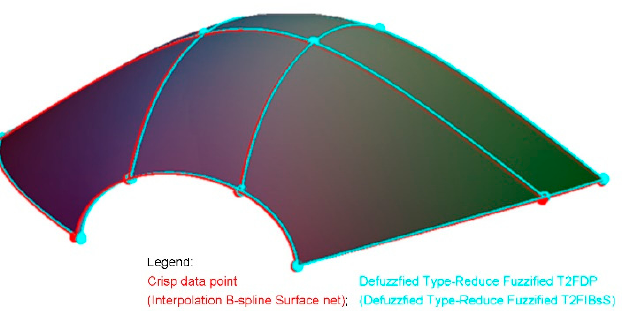
Figure 10. The example of defuzzification-reduced T2FIBsS with defuzzification-reduced